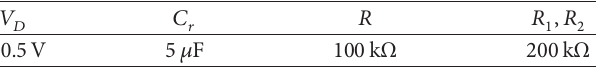
Figure 8: The second-class system-level coupled model of the PVEH system. Table 1: Component parameters of the parallel SSHI circuit.